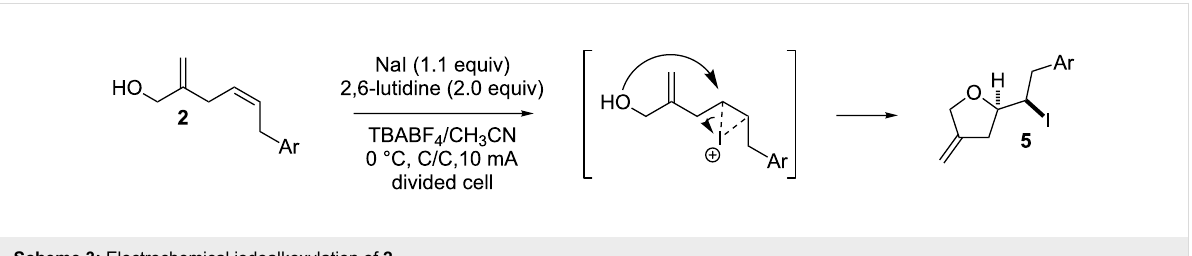
Scheme 3: Electrochemical iodoalkoxylation of 2